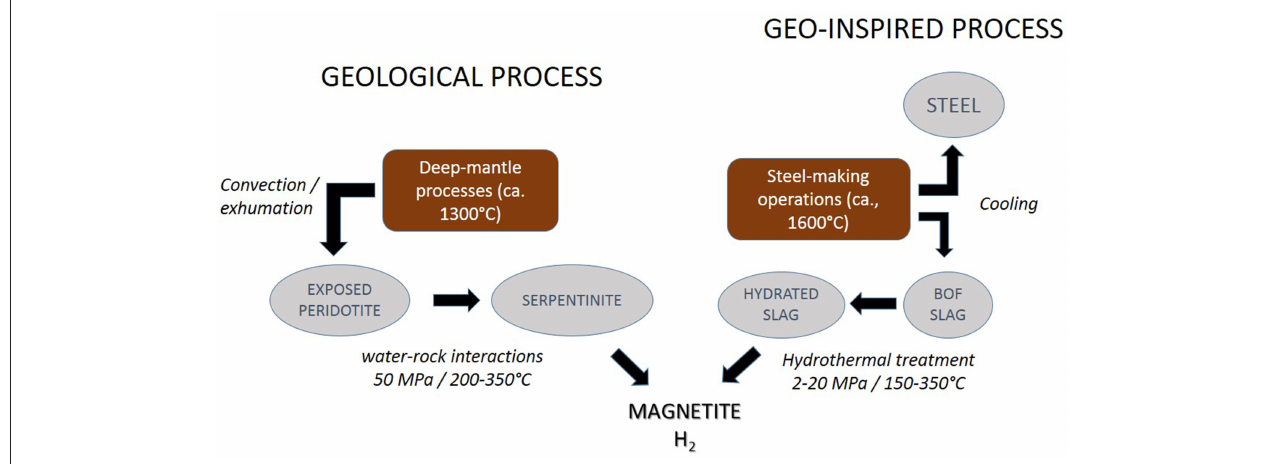
FIGURE 1 | General scheme of H 2 and magnetite production by serpentinization and by its geo-inspired counterpart process which is based on the hydrothermal treatment of steel slags (here BOF).